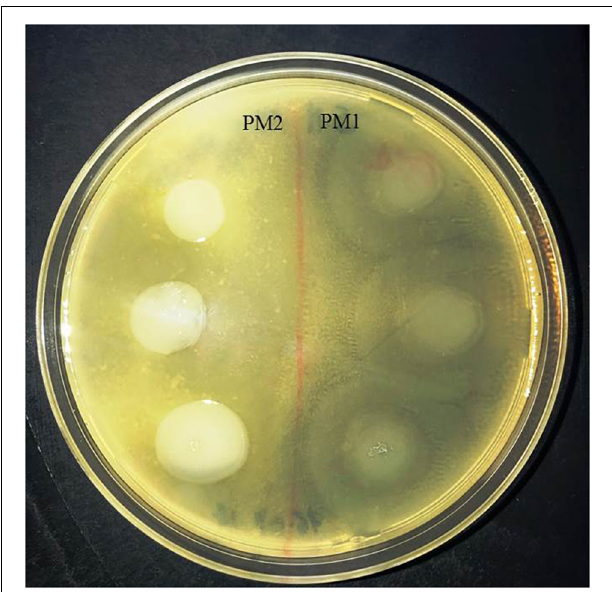
FIGURE 3 | Skimmed milk agar test. Around the colonies of only PM1 large clear zone, due to the proteolysis of casein, are clearly visible.